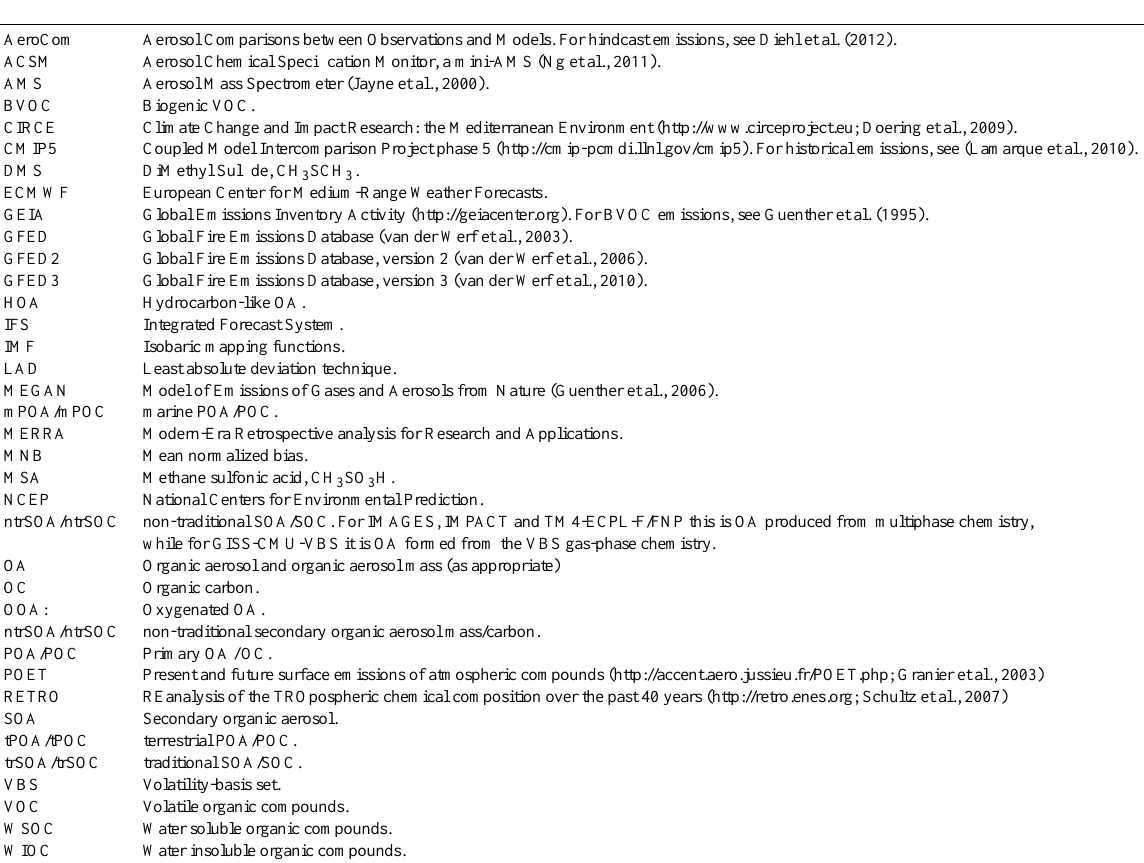
Table A1. List of